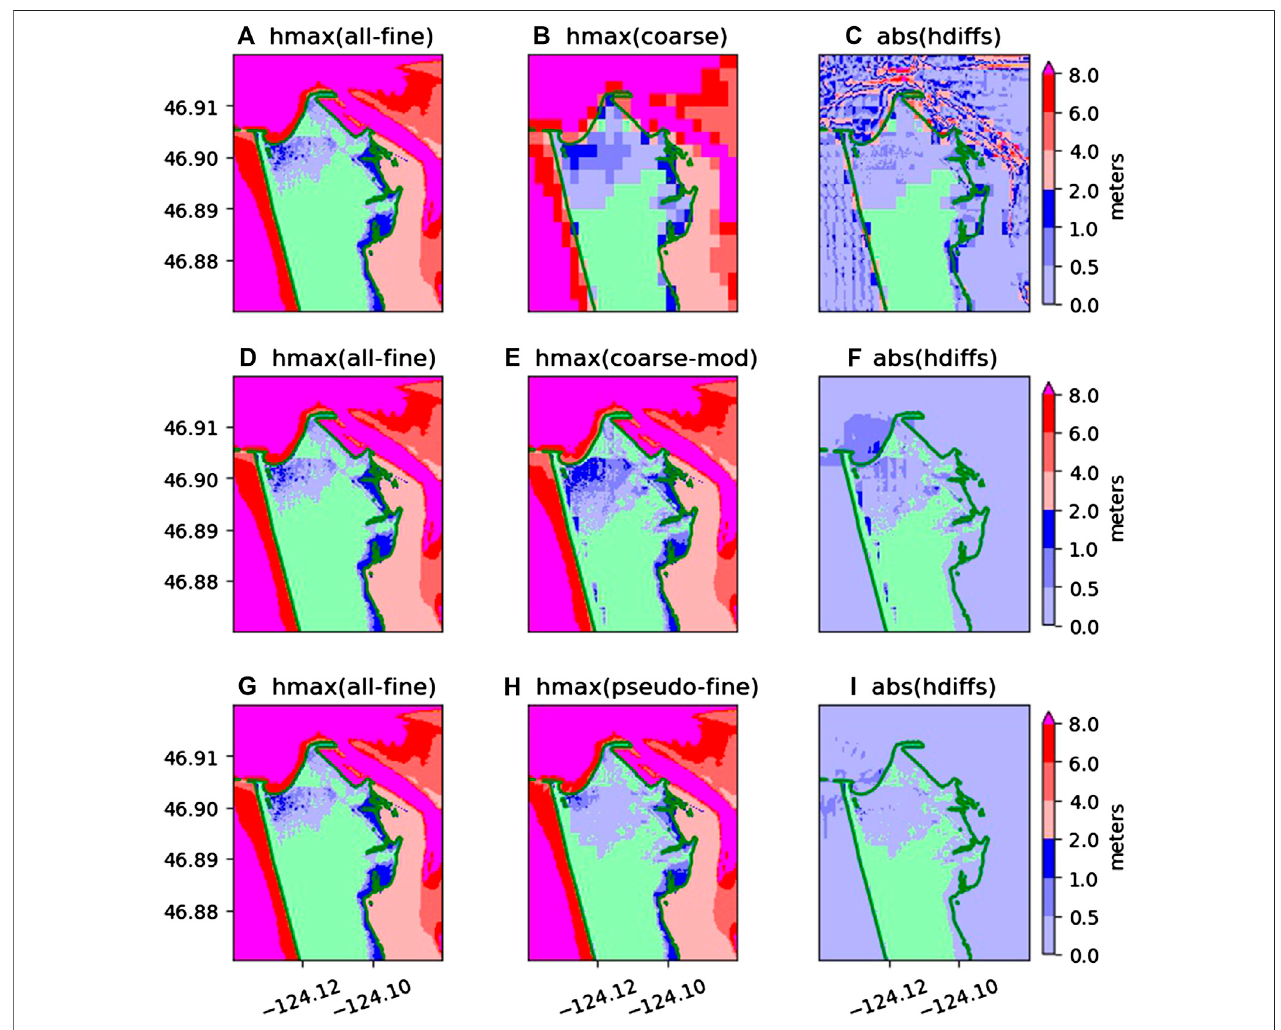
FIGURE 5 | Sample results for realization 1,665 at Westport, where the tsunami was small. (A, D, G) h f max (B) h c max (E) h c max after coarse-mod corrections. (H) h c max after pseudo- fi ne corrections. (C, F, I) Errors relative to h f max . Purple is above 8 m and Green is land not inundated. See the text for more explanation.